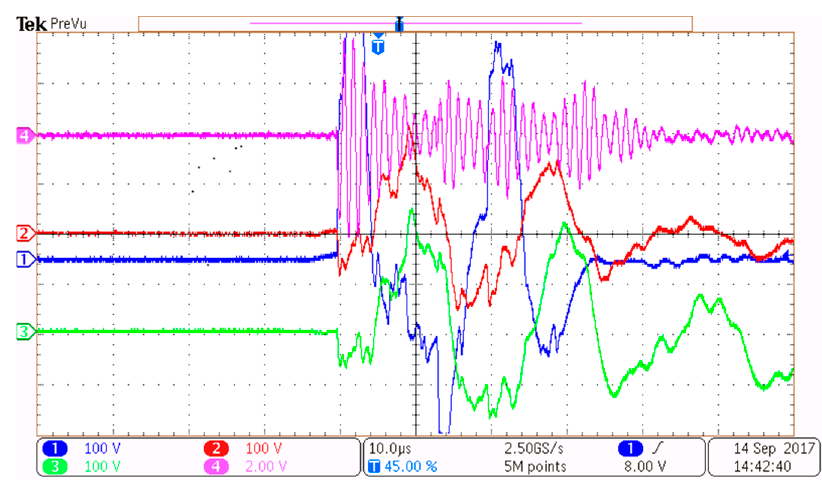
Figure 11. TWs captured through the oscilloscope.